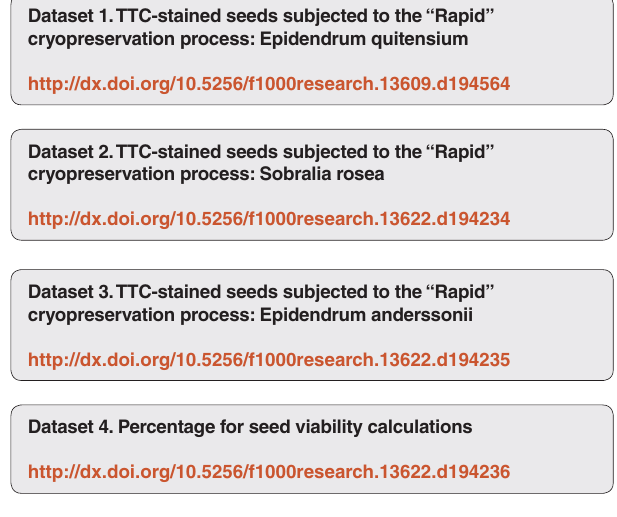
Table 3. Cryopreservation of orchid seeds. Values represent percentage of viability assessed by the TTC method, N: cryo